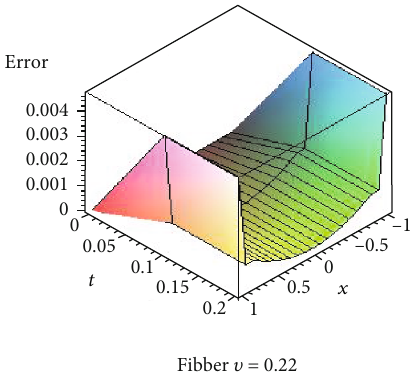
Figure 8: The value absolute error by TMM at N = 20 and T = 0 : 2 .